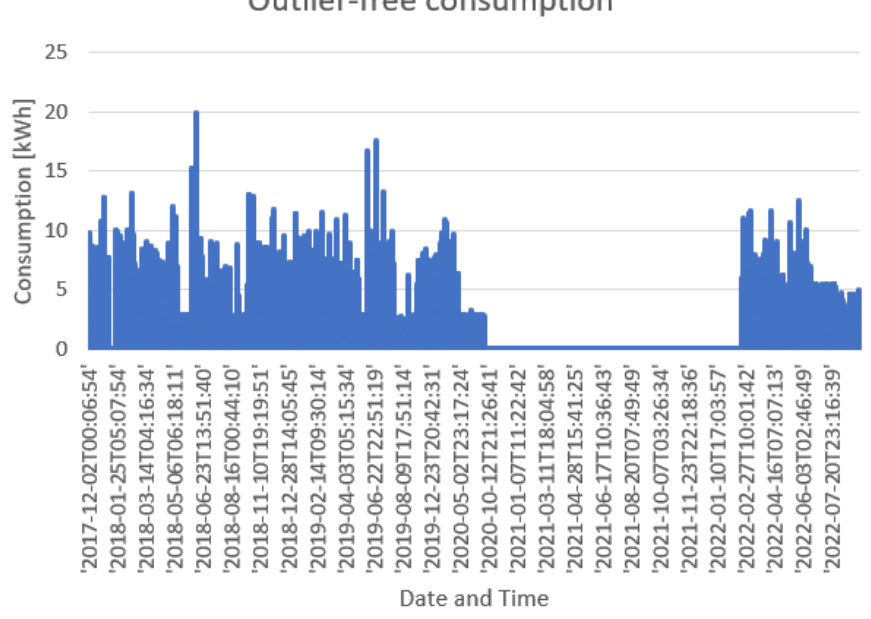
Figure 4. Electricity consumption without outliers from the Faculty of Building Services.